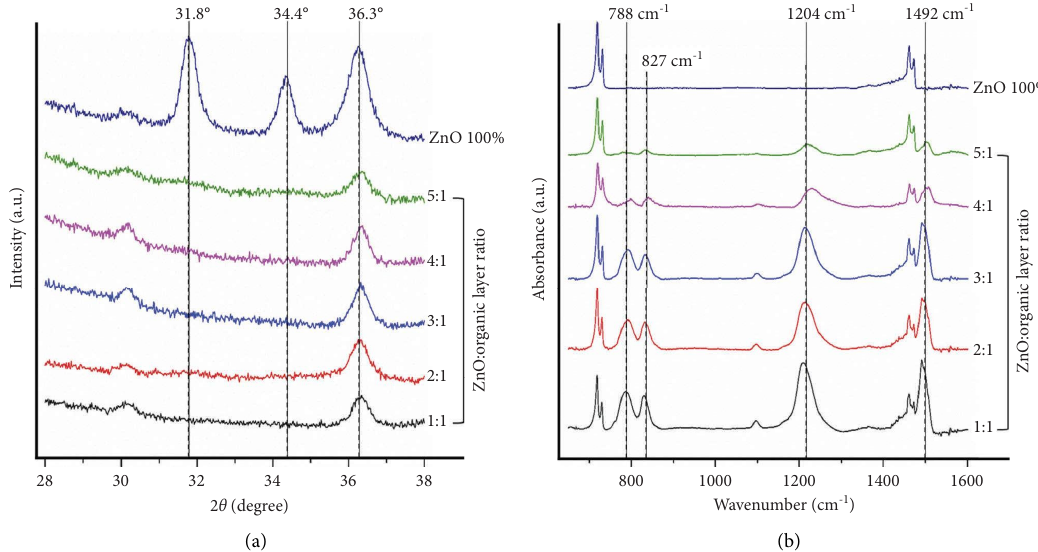
Figure 5: (a) GIXRD, and (b) FTIR measurements of pure ZnO flm and hybrid flms with various ratios are